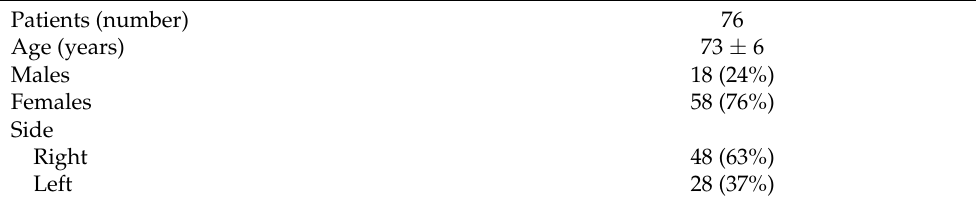
Table 1. Characteristics of study